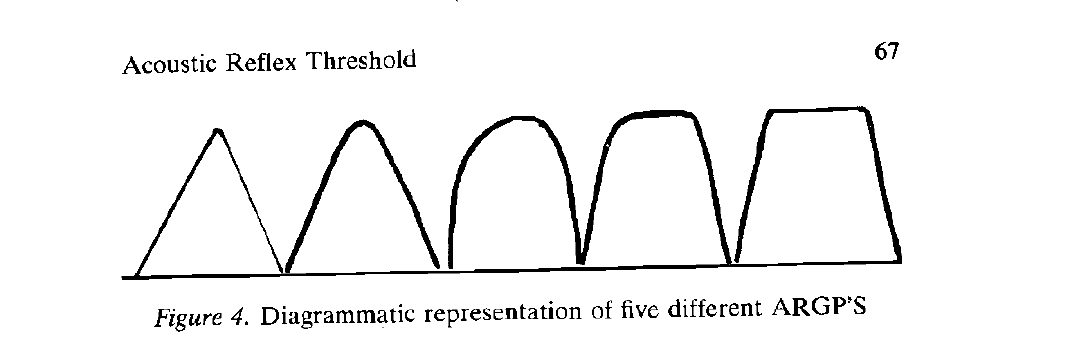
TABLE II: Frequency Distribution of ARGP's in the CG and EG Ears CG CG EG % Total ARGP Peaked 29,5% 8,5% 38% Rounded 10,5% 9,5% 20% Peaked-Rounded 12,5% 3,75% 16,25% Flat 2,75% 10,75% 13,5% Rounded-Flat 0% 7,25% 7,25% No Growth 2,75% 2,25% 5% Total 58% 42% 100%